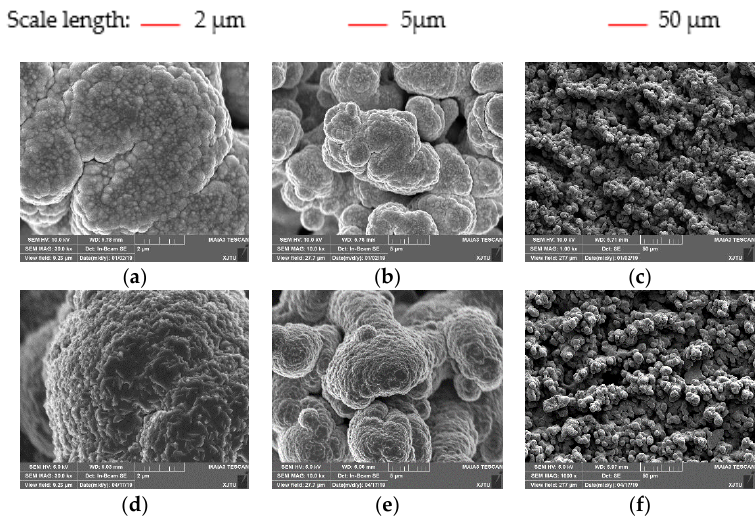
Figure 2. The SEM (Scanning electron microscope) micrographs of the Ti–Zr–V–Hf and Ti film coatings with cleaned laser processed OFHC substrates. (a) , (b) and (c) are the SEM images of Ti–Zr–V–Hf film coatings. (d) , (e) and (f) are the SEM images of Ti film coatings.